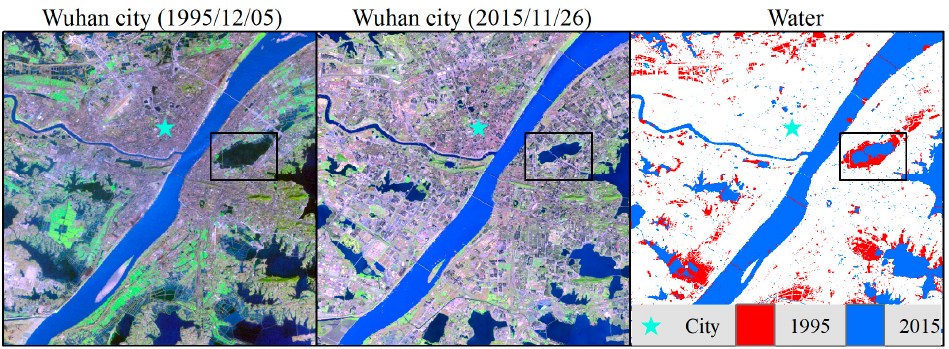
Figure 14. The losses in water bodies due to urban expansions in Wuhan city.